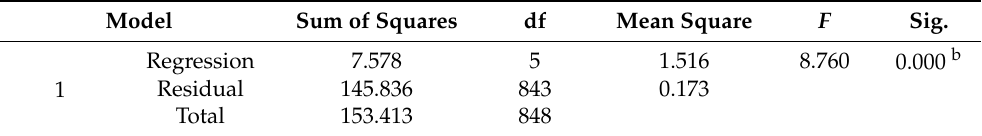
Table 4. Analysis of variance of the constructed mathematical model. Model Sum of